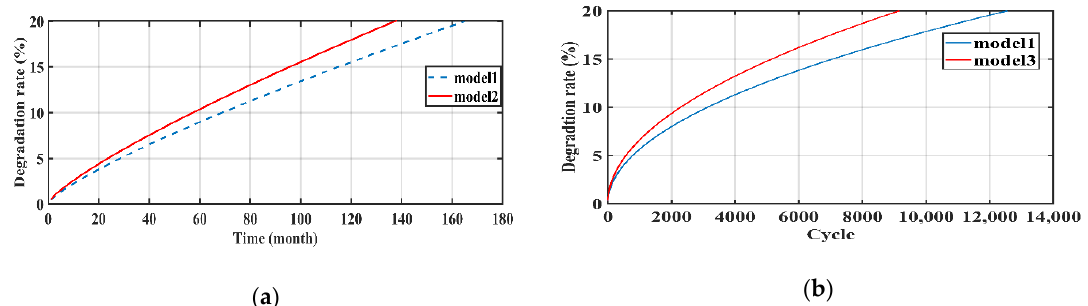
Figure 4. Degradation rate by model: ( a ) Calendar degradation and ( b ) cycle degradation.